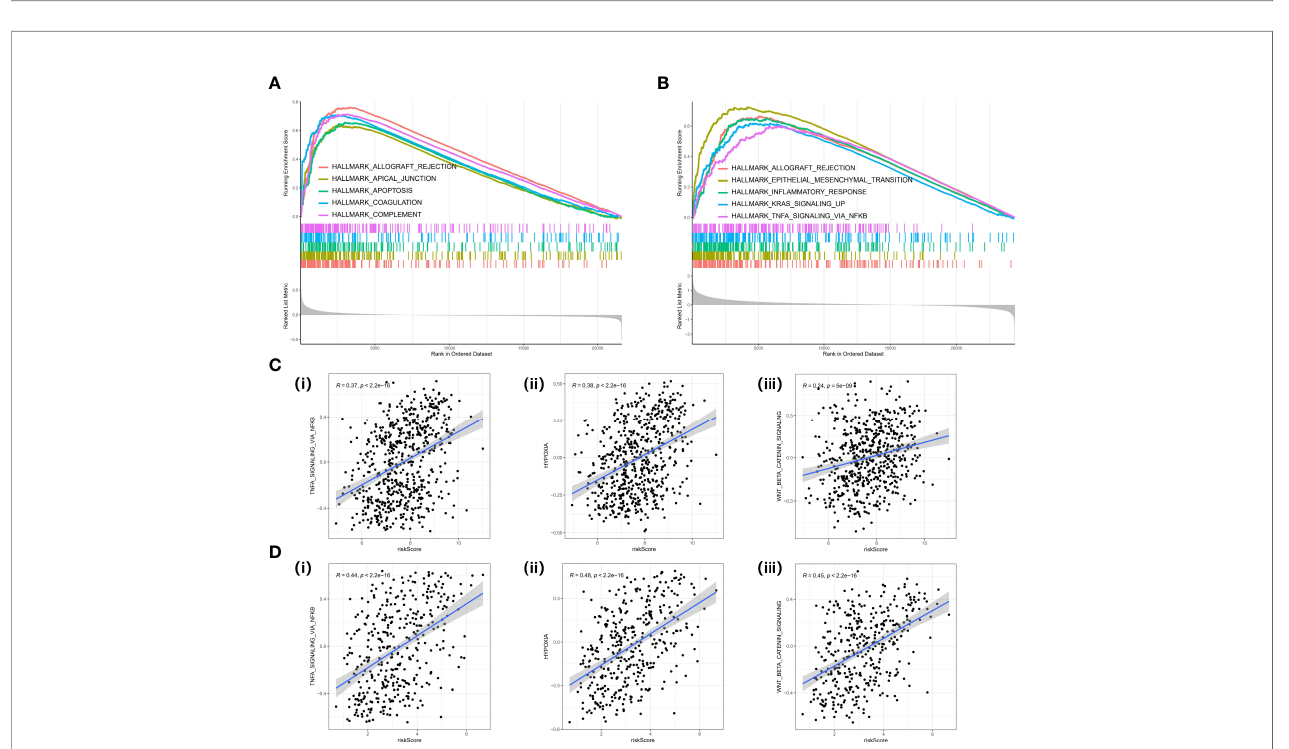
FIGURE 8 | GSEA in cancer hallmark gene set. (A) GSEA plot in the GPL570 meta-cohort. (B) GSEA plot in TCGA-OV cohort. (C) Correlation analysis between risk score and TNF signaling (i), hypoxia (ii), EMT (iii) in the GPL570 meta-cohort. (D) Correlation analysis between risk score and TNF signaling (i), hypoxia (ii), and EMT (iii) in TCGA-OV cohort. GSEA, Gene Set Enrichment Analysis; TNF, Tumor Necrosis Factor; EMT, Epithelial to Mesenchymal